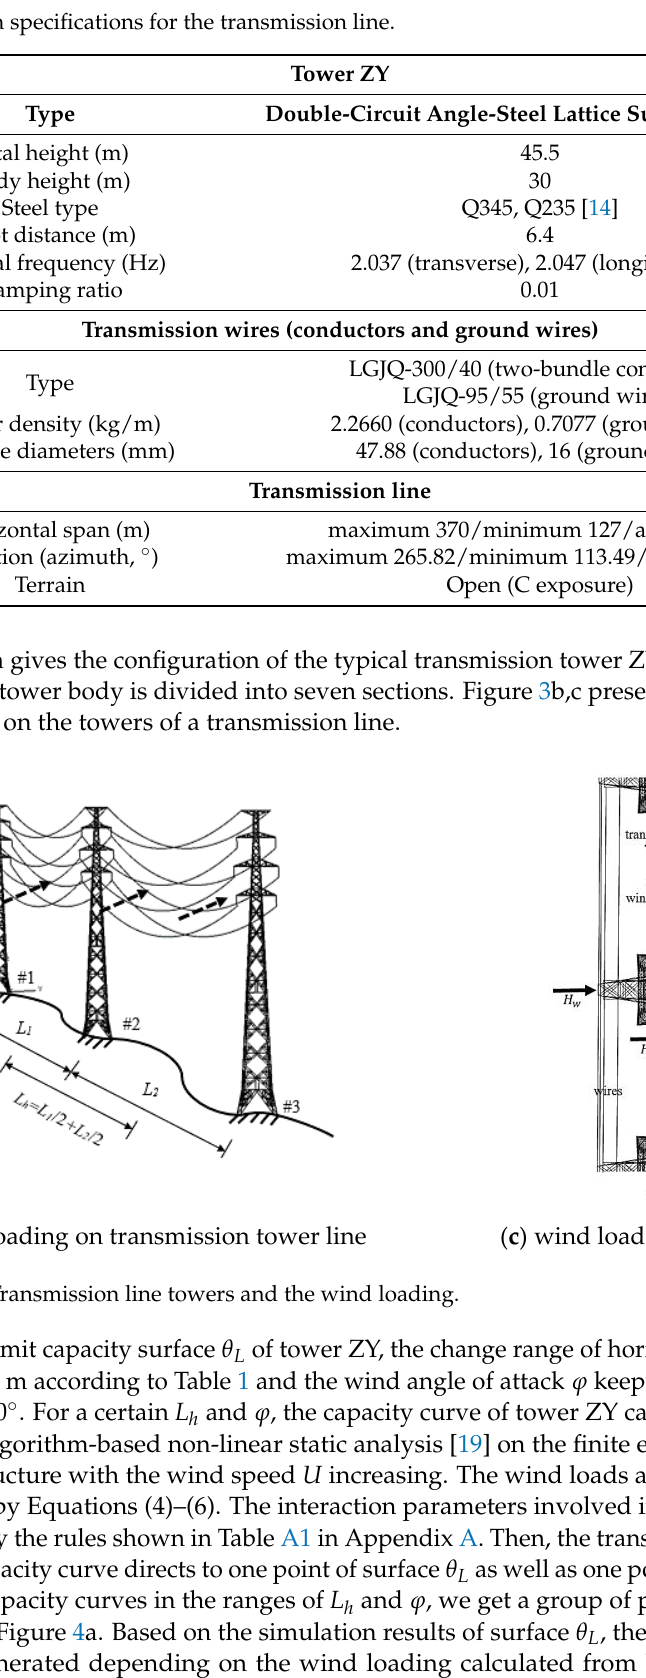
Table 1. Design specifications for the transmission line.